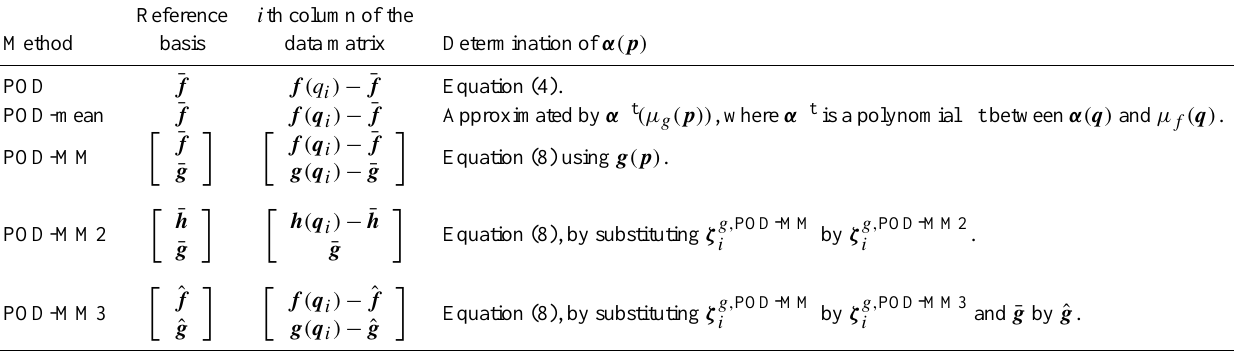
Table 1. Summary of differences between various methods used for constructing ROM. In the table below, f is the fine-resolution solution; g is the coarse resolution solution; h is given by Eq. (10); ˆ f and ˆ g are given by Eq. (15); p is any given parameter set; q i is the i th parameter set in S N ; µ f ( p ) and µ g ( p ) are spatially averaged f ( p ) and g ( p ) ; and ζ g, POD POD-MM, POD-MM2 and POD-MM3 methods, respectively. (Please refer to each method’s subsection in Sect. 2 for more details on the above